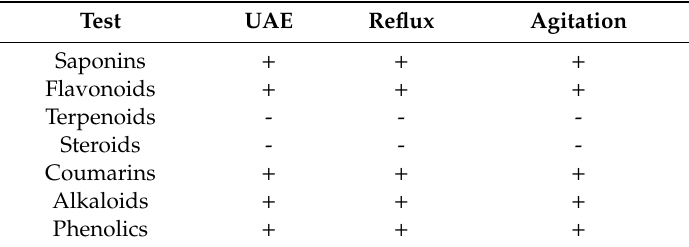
Table 3. IC 50 of 2, 2-diphenyl-1-picrylhydrazyl (DPPH) radical scavenging activity of C. papaya leaves extracts. Table 2. Secondary metabolites of C. papaya leaves extract.